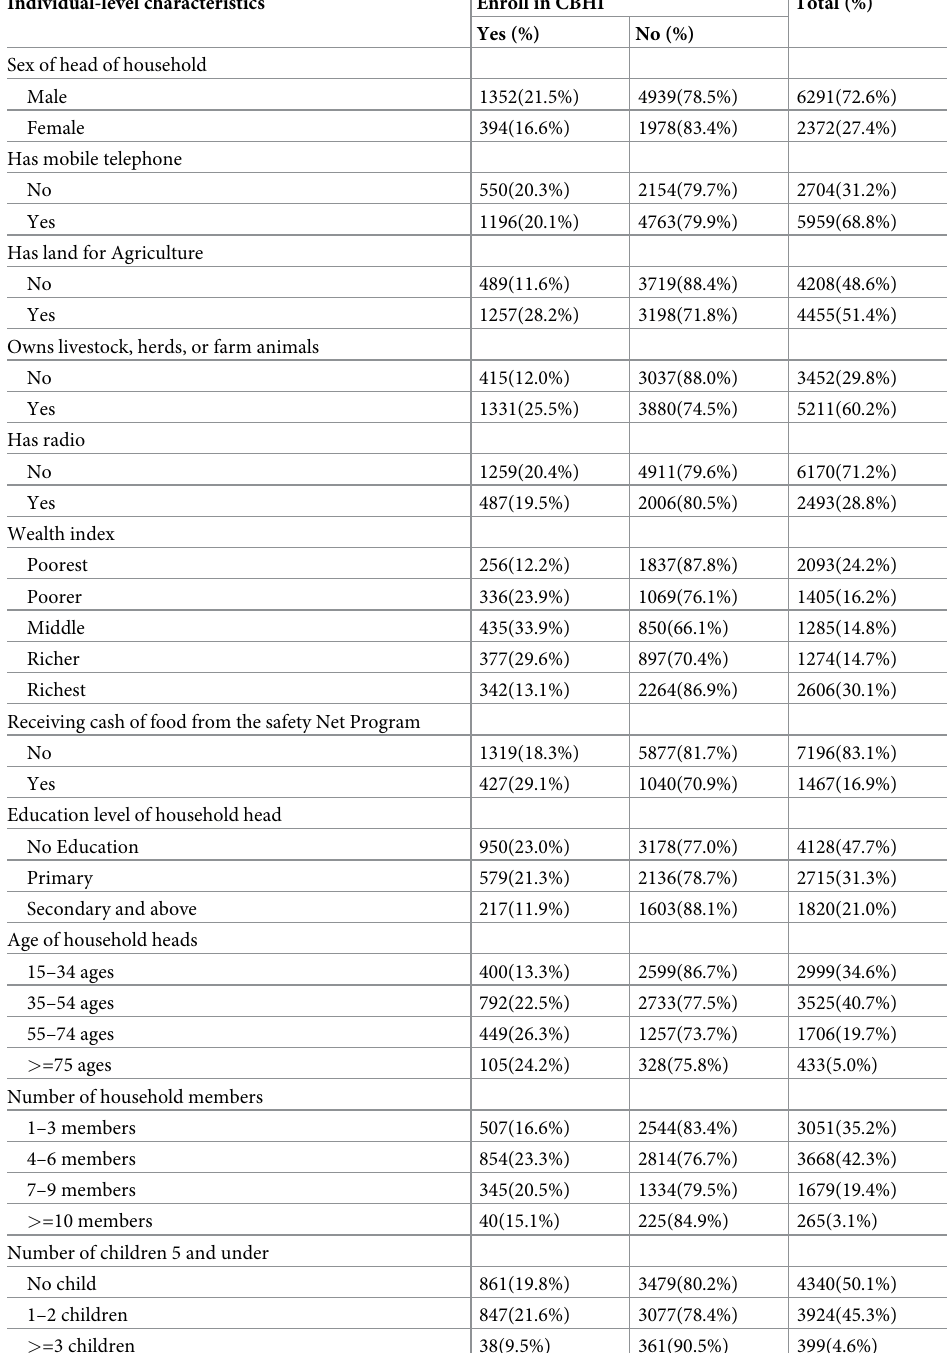
Table 1. Characteristics of individual-level factors of CBHI enrollment, Mini-EDHS